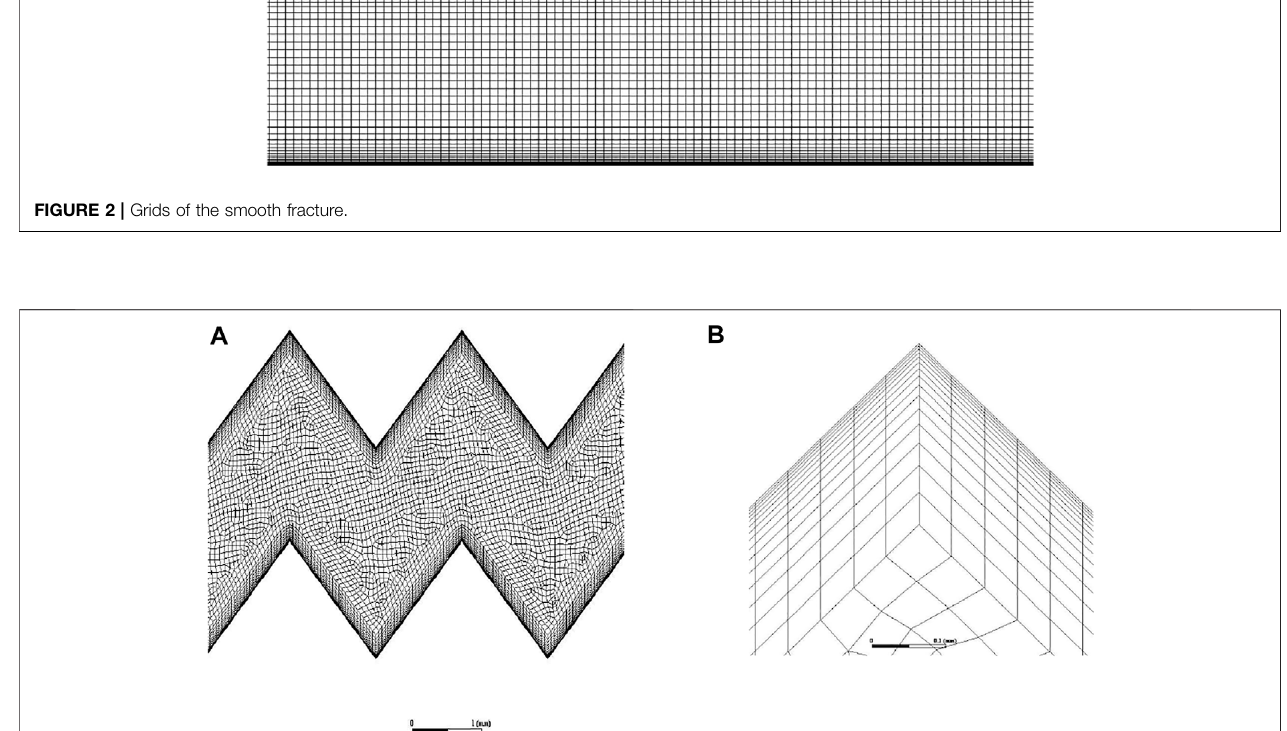
FIGURE 3 | Grids of the rough fracture. (A) Grids of the rough fracture; (B) boundary grids of the rough